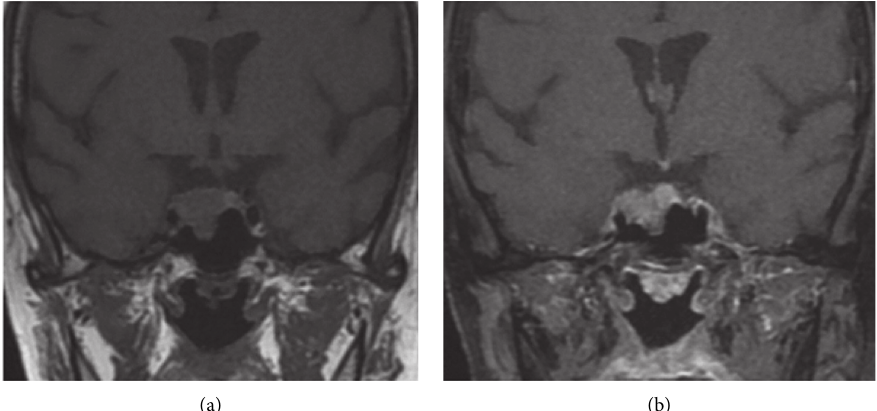
Figure 1: Pregadolinium (a) and postgadolinium (b) T1-weighted coronal images of pituitary MRI showing 17mm adenoma with right cavernous sinus invasion and sellar floor